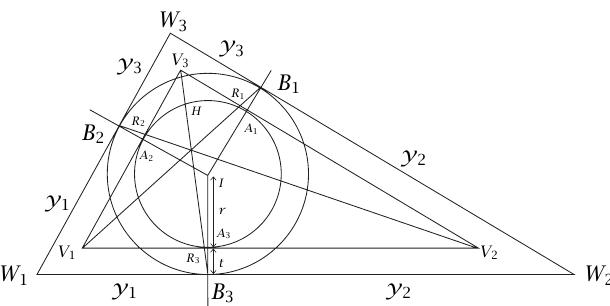
Figure 5 . The geometry of ∆ V 1 V 2 V 3 and W 1 W 2 W 3 .